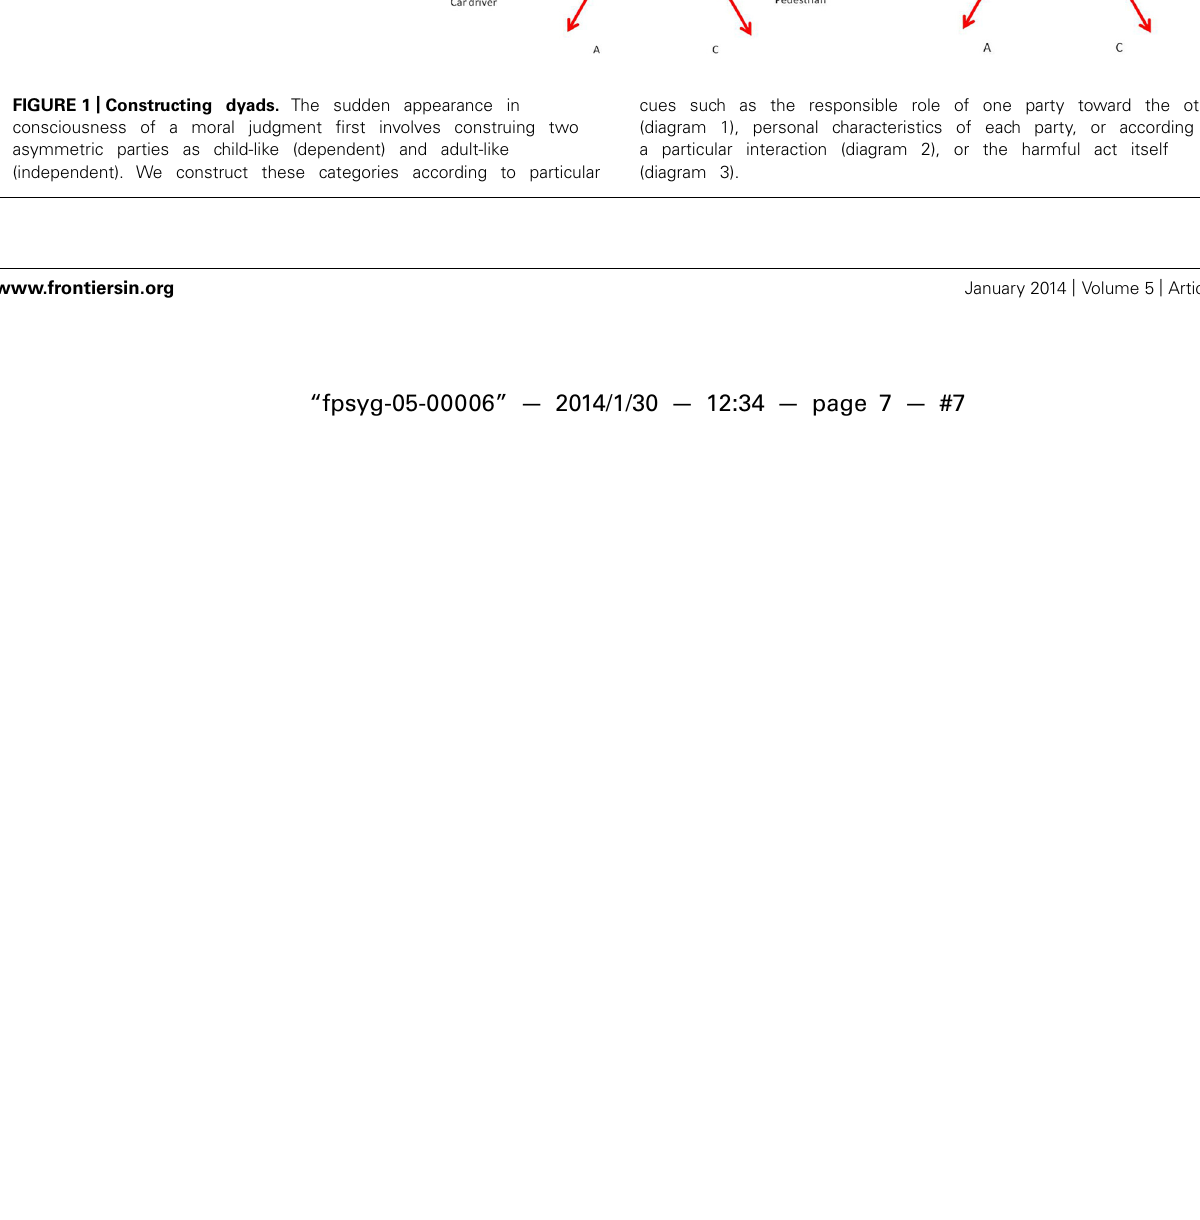
cues such as the responsible role of one party toward the other (diagram 1), personal characteristics of each party, or according to a particular interaction (diagram 2), or the harmful act itself (diagram